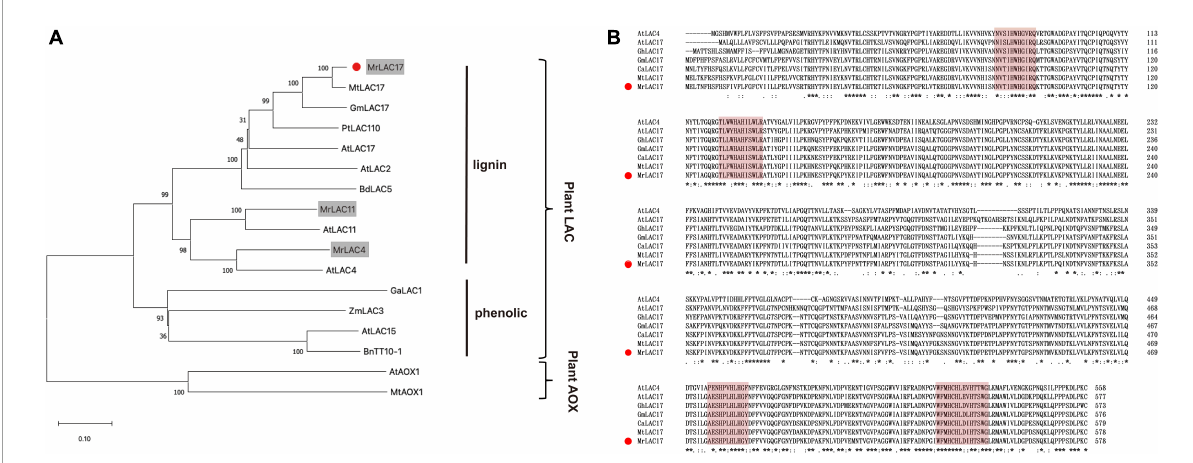
FIGURE5 Amino acid sequence alignment and phylogenetic tree between MrLAC17 and other species laccases. (A) The distance matrix was clustered using the neighbor-joining method in MEGA software. Bootstrapping set to 1,000 replicates. M. ruthenica putative laccases are shown on gray background, and MrLAC17 is marked with red dots. The tree is rooted by the ascorbate oxidase sequences as outgroup. Bar indicates relative branch length. (B) Alignment was carried out between MrLAC17 protein and other laccases protein sequences using Clustal Omega, and optimized manually. Numbers indicate the position of the last amino acid in each line of the proteins. The * identical amino acids; or, similar amino acids and **, ***, ****, *****, ******, and ******* indicated that consecutive amino acids were identical (or similar). The copper-binding domains are shaded in red color, and MrLAC17 is marked with red dots.